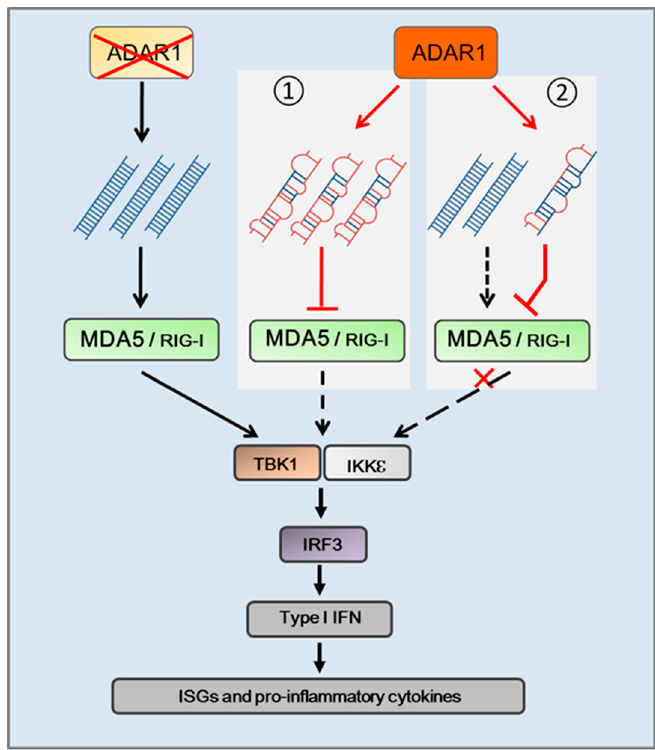
Figure 2. Hypothesis of the mechanism by which cellular endogenous RNA edited by ADAR1 silences cytosolic RNA sensing signaling pathway. In the condition of ADAR1 deficiency, endogenous dsRNA stimulates cytosolic RNA receptors to elicit innate immune response. RNA editing by ADAR1 changes the dsRNA structures by introducing mismatched I-U base pairs into the RNA transcript, which replace A-U pairs in perfect dsRNA. If editing is sufficient to nullify all immune active RNAs, the corresponding receptors remain unstimulated, as shown in box 1. If RNA editing efficiency is low, the edited dsRNA will need to be high capacity to inhibit the stimulation from the unedited immune active RNAs, as shown in box 2.